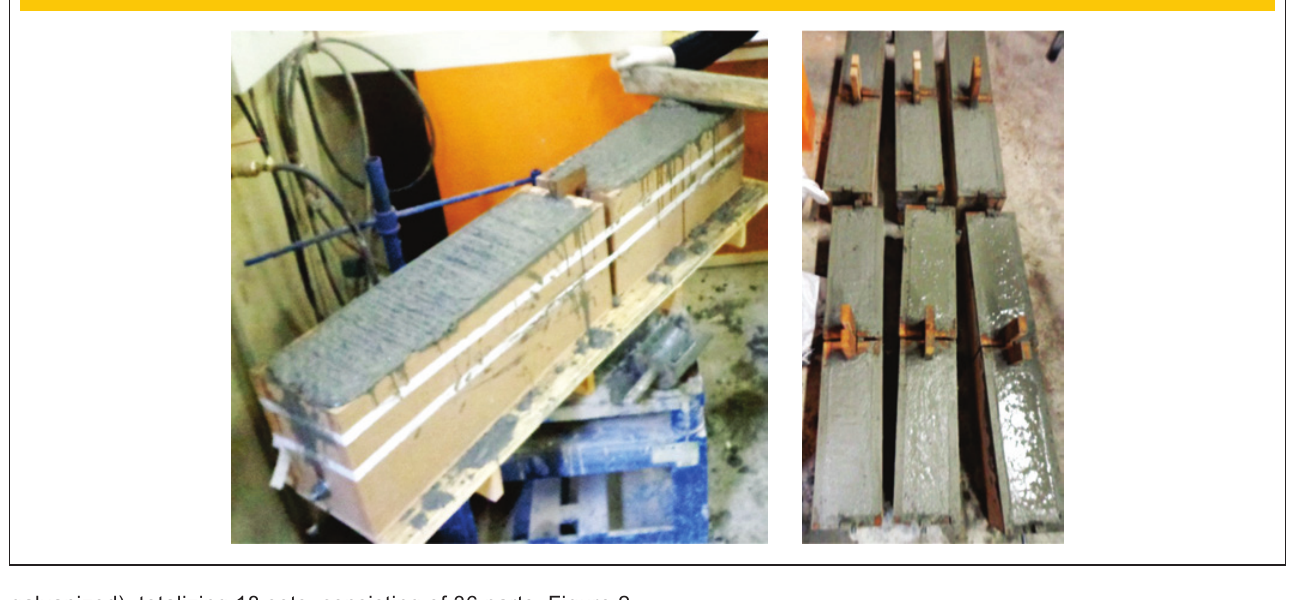
Figure 2 – concrete placement set beams for testing adherence between the bars and the